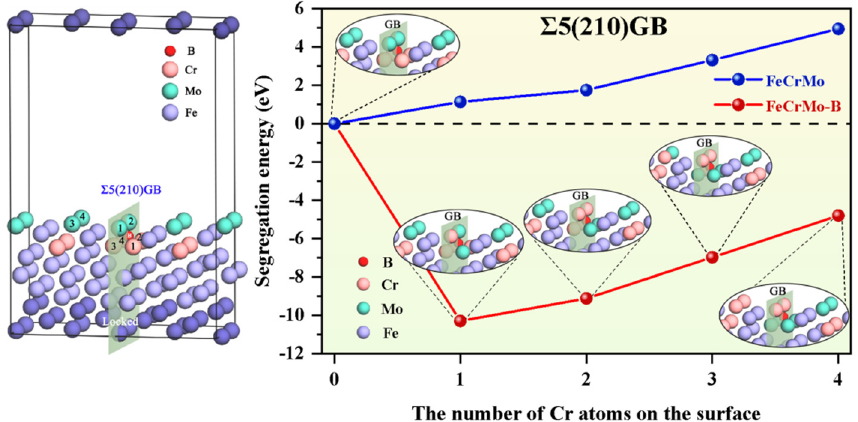
Figure 9. Microstructural models of FCC–FeCrMo(–B)(100) with a Σ 5(210) GB and the segregation energy of Cr diffusion to the surface.